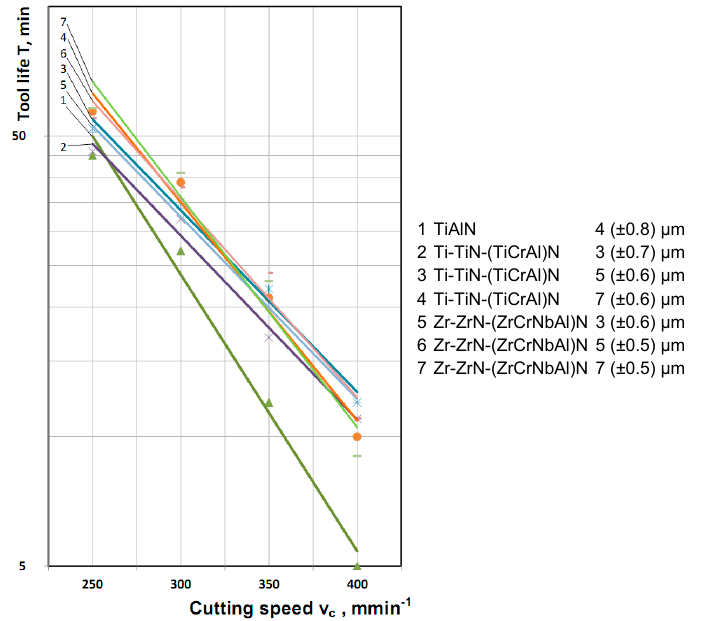
Figure 8. Cutting speed v c —tool life T curve at cutting speeds of v c = 250, 300, 350, and 400 m·min − 1 ( f = 0.2 mm/rev; а p = 1.0 mm, longitudinal turning of steel C45).